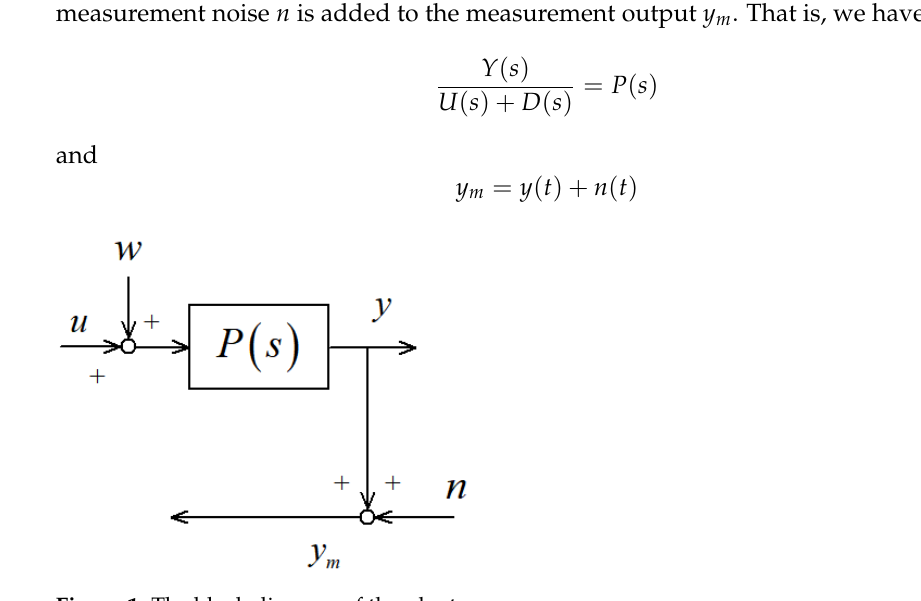
Figure 1. The block diagram of the plant.